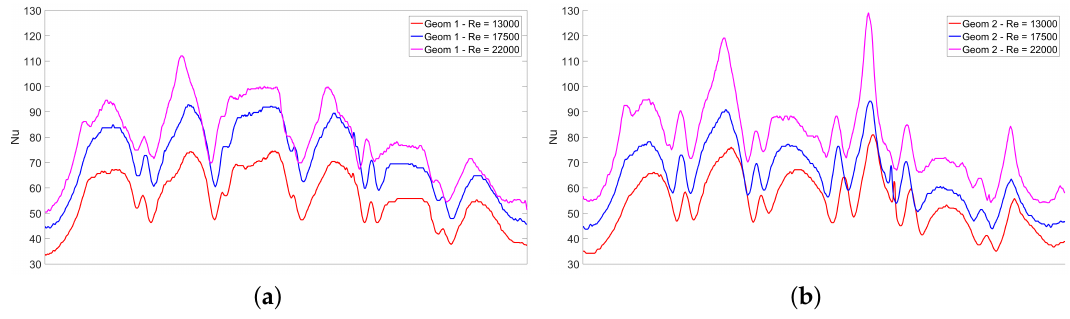
Figure 10. Comparison of measured Nusselt number distributions on line near to impingement peaks for geometries 1 and 2 with Re = 13,000, 17,500 and 22,000. ( a ) Geometry 1; ( b ) Geometry